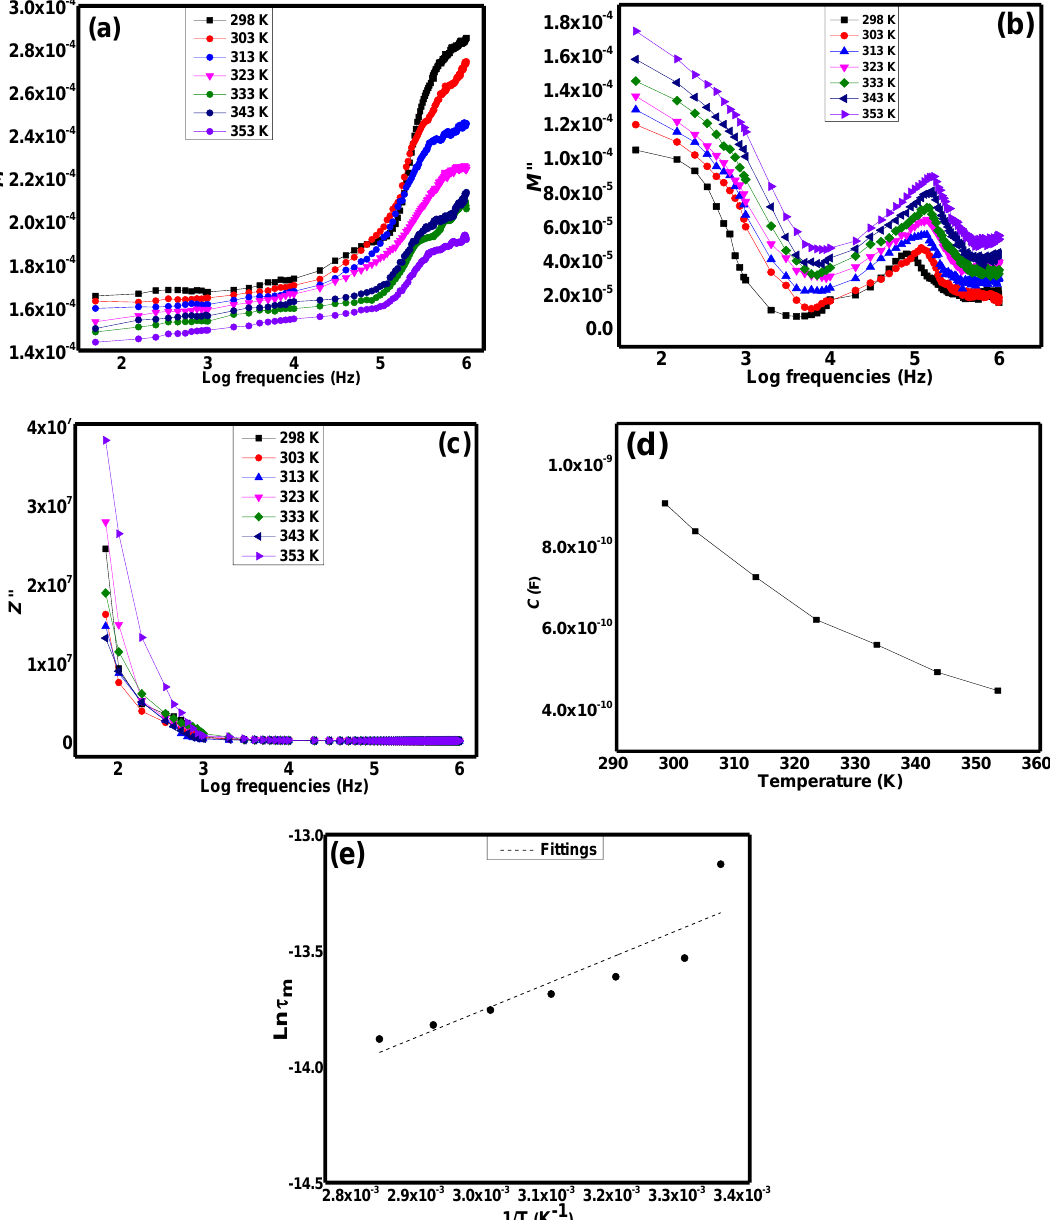
Figure 7. ( a ) The real, ( b ) imaginary electrical modulus, ( c ) reactance impedance against different frequency logarithmic, ( d ) capacitance values at various temperatures, and ( e ) ln relaxation times vs. inverse in temperature of Sr 2 CaTeO 6 .